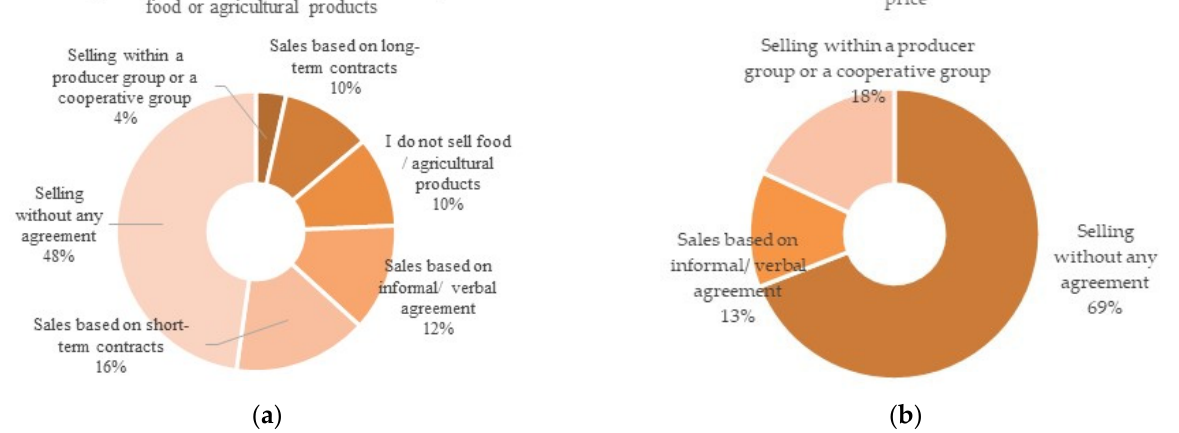
Figure 2. Type of relations with the market of Lithuanian small farms when selling food or agricultural products ( a ) or choosing the distribution channel to help reach higher selling prices ( b ) (N = 1002).